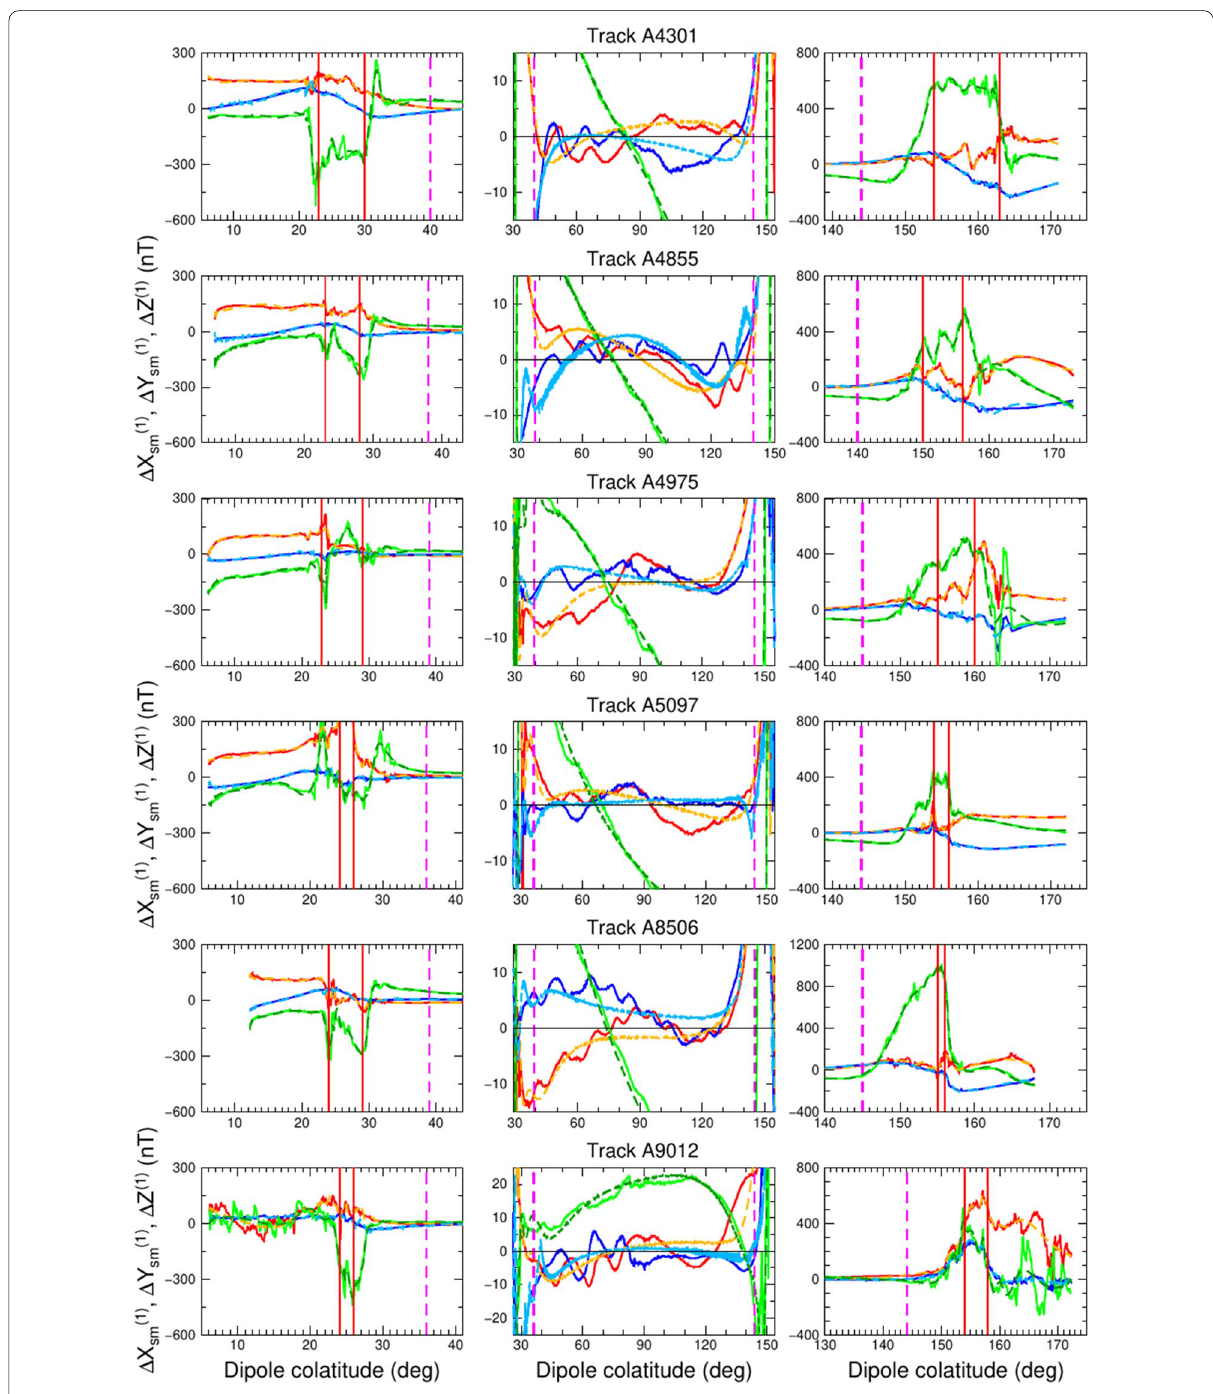
Fig. 12 The same as Fig. 10, but for α 2 = 3 × 10 − 15 nT 2 A −